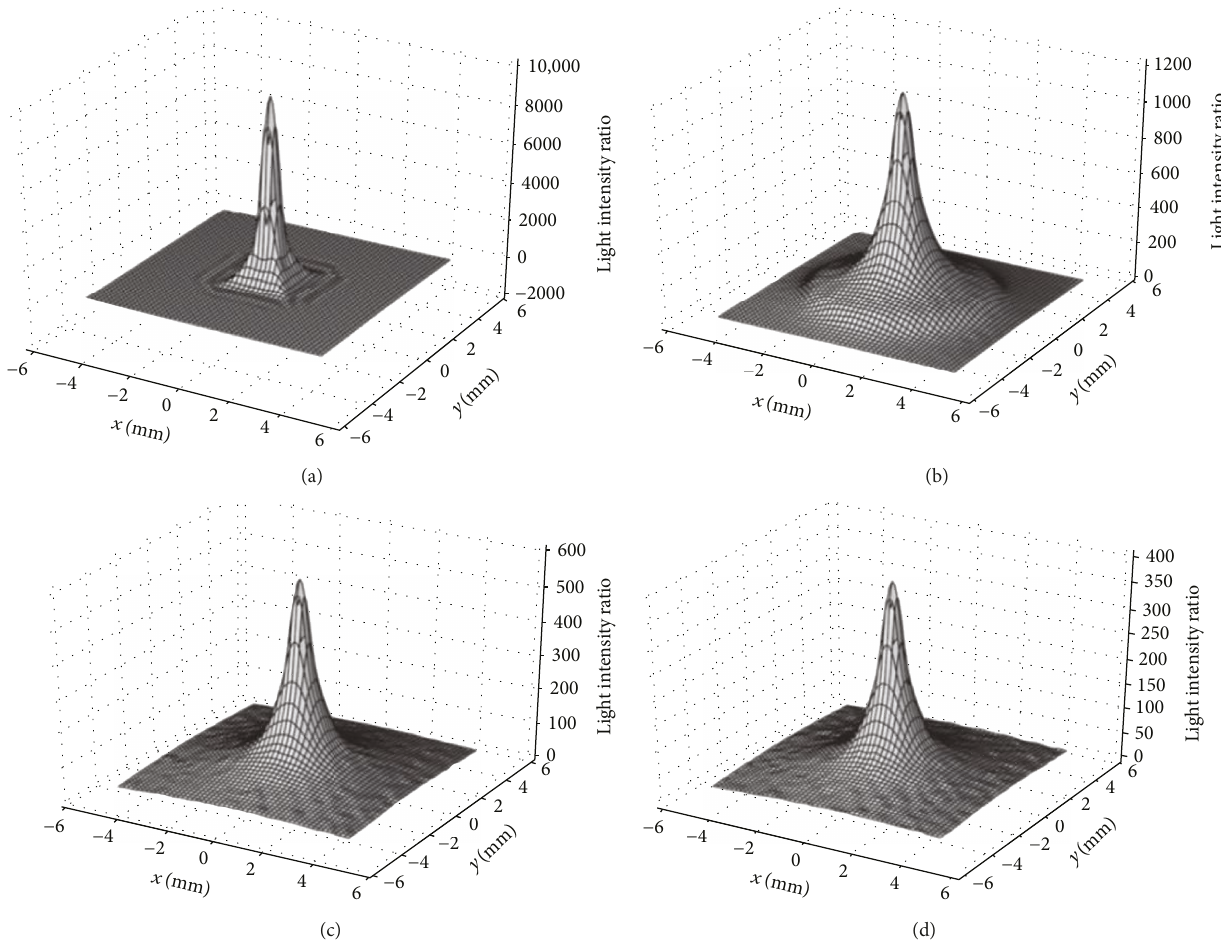
Figure 6: The distribution of the light intensity ratio on the surface of a solar cell at the focal point under the AM1.5d spectrum distribution; the width of the cell is 10 mm. (a) Divergence angle at 0 ° . (b) Divergence angle at 1 ° . (c) Divergence angle at 2 ° . (d) Divergence angle at 3 °